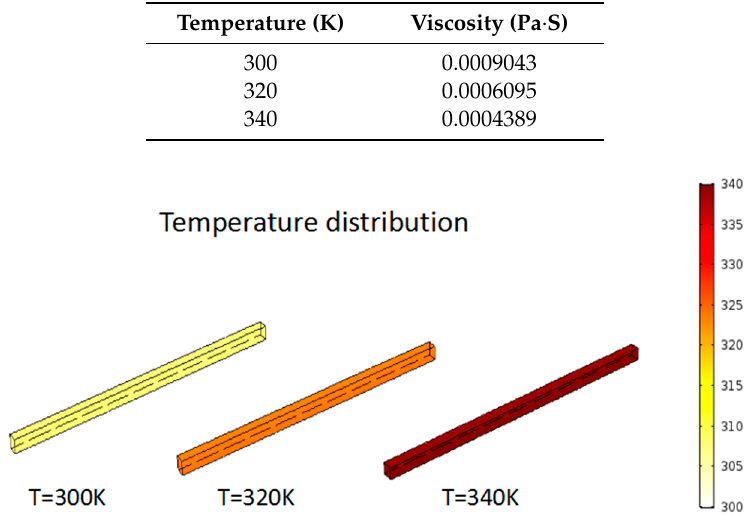
Table 2. Methanol solution viscosity at different temperatures.